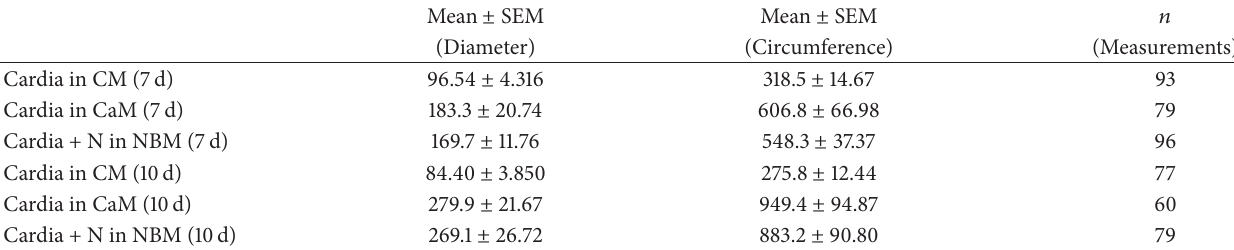
Table 2: Measurements of organoid size and circumference at 7 d and 10 d in 𝜇 m, 𝑛 = 3